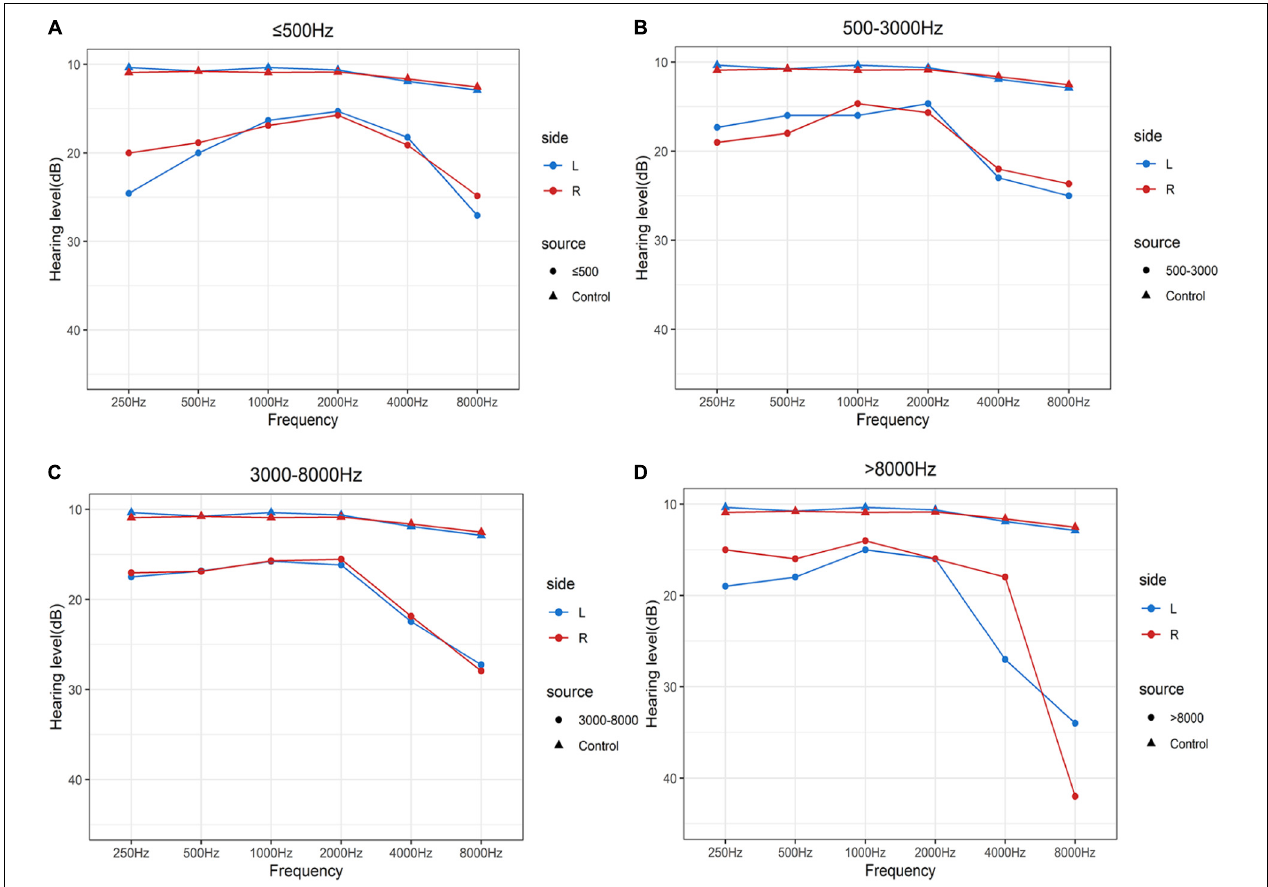
FIGURE 1 | Average pure-tone audiograms of patients with clinically normal hearing and volunteers without tinnitus using a 250–8,000 Hz conventional audiometer. (A–D) Mean values of average hearing thresholds for the controls with normal hearing and without tinnitus and patients with clinically normal hearing in dominant tinnitus pitch ≤ 500 Hz (A) , 500 Hz–3 kHz (B) , 3–8 kHz (C) , and > 8,000 Hz (D) . Blue solid lines and dots represent left ears and red solid lines and dots represent right ears in patients with tinnitus. Blue solid lines and triangles represent left ears and red solid lines and triangles represent right ears in volunteers with normal hearing and without tinnitus.